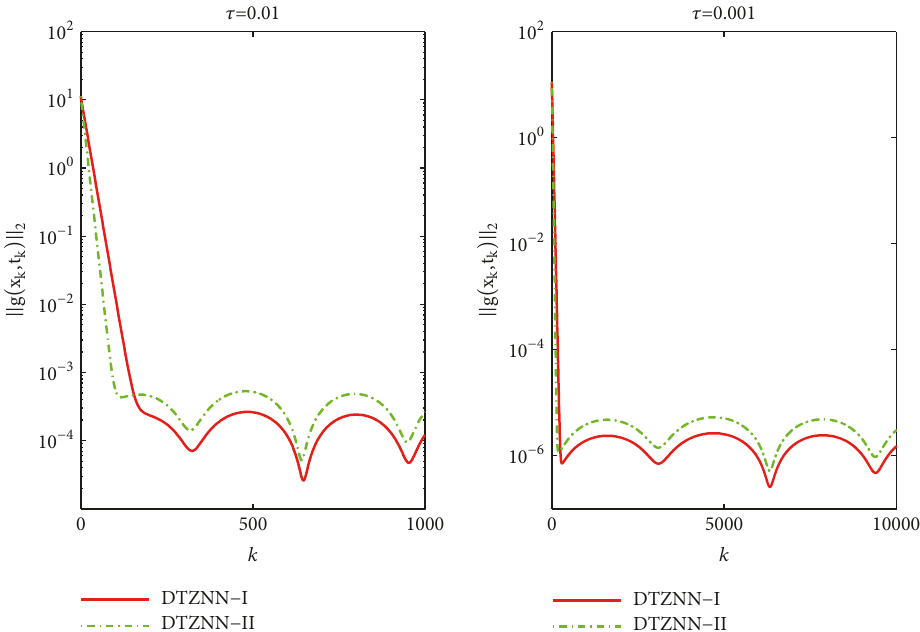
Figure 2: Trajectories of SSRE ‖𝑔(𝑥 𝑘 , 𝑡 𝑘 )‖ 2 of problem (50) generated by the DTZNN models (14) and (18), left 𝜏 = 0.01 , right 𝜏 = 0.001 .